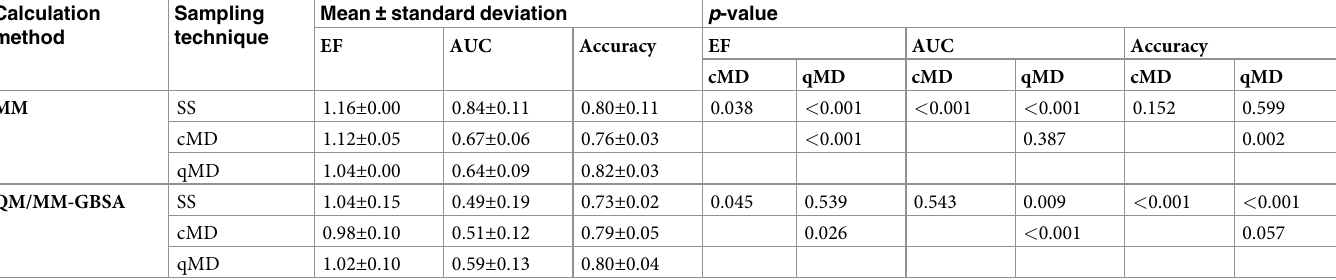
Table 2. Impact of sampling technique on the discerning ability of binding affinity estimation approaches. SS: single structure; cMD: classical MD; qMD: QM/MM MD. Calculation Sampling method